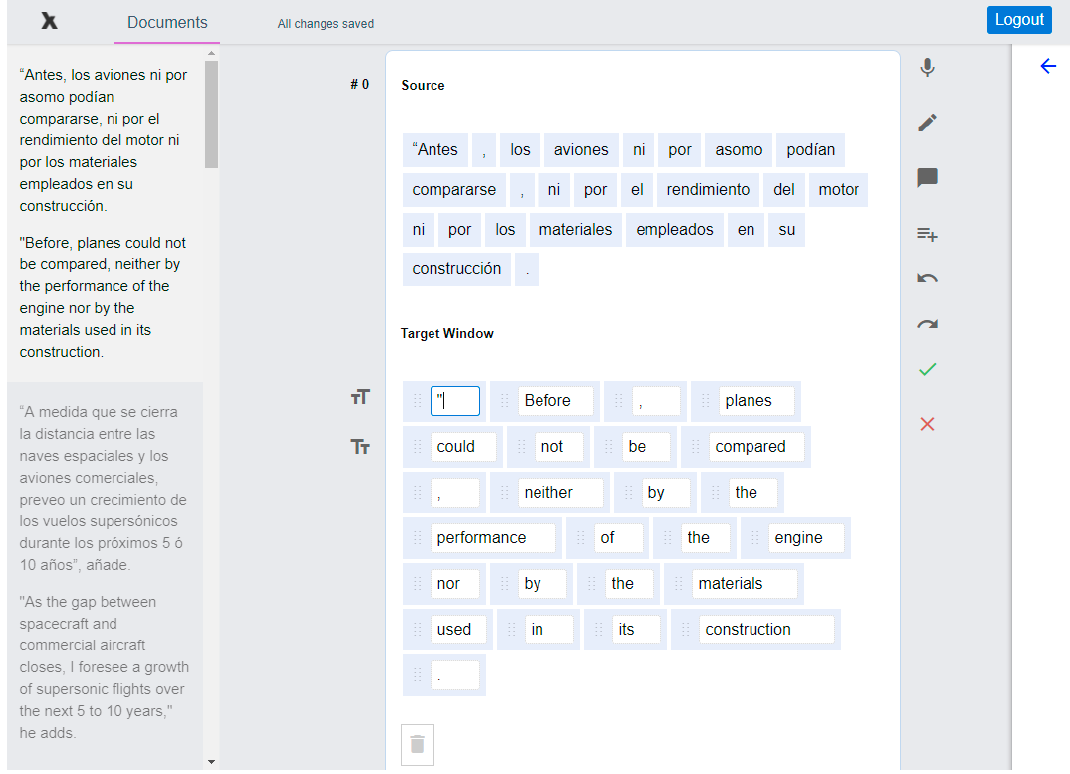
Figure 12. The Tile view in the second iteration of the tool.